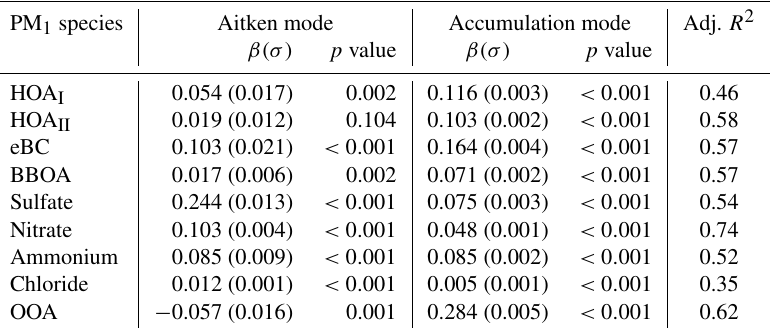
Table 5. Fit parameters of MLR model results between PM 1 components (species of interest) and volume of aerosol size modes (predictors) and adjusted R 2